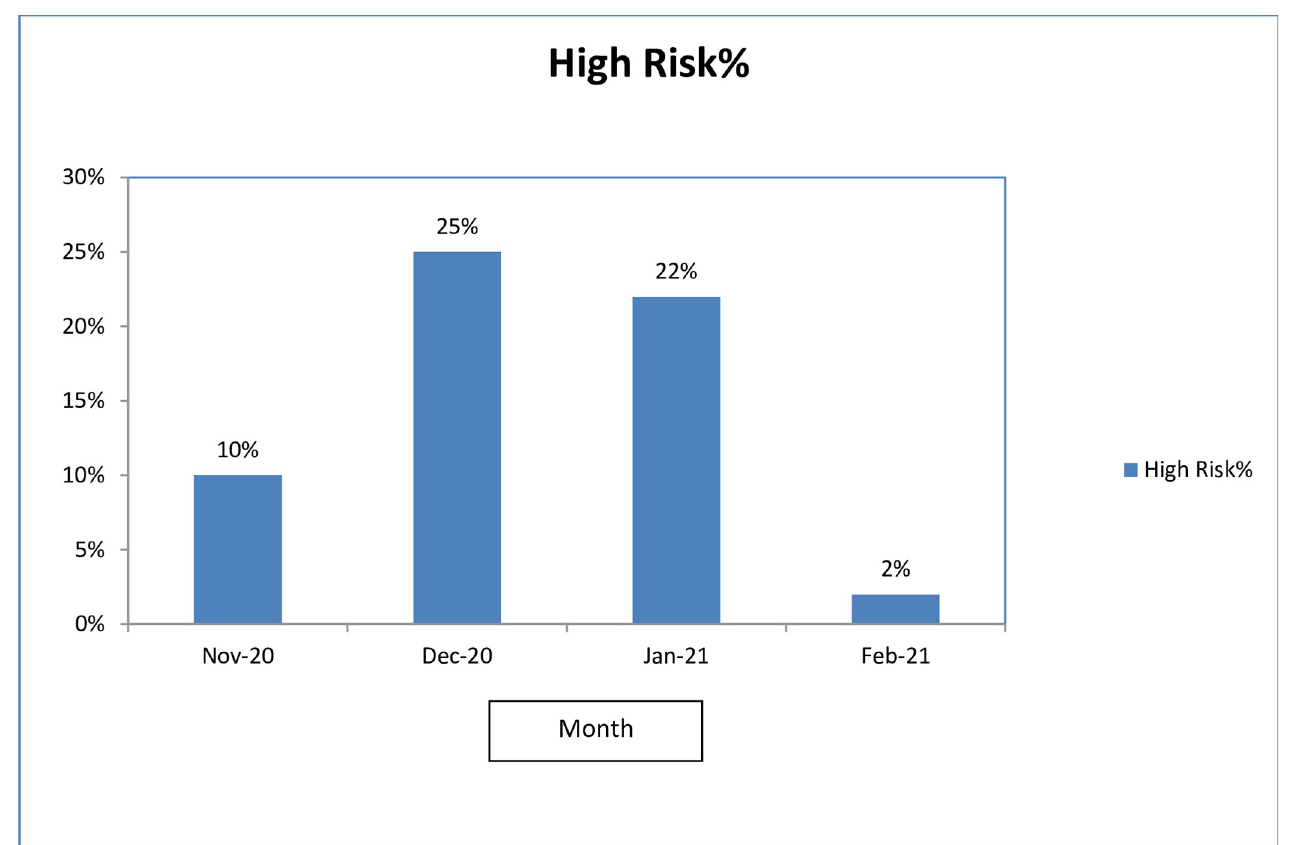
Fig 4. Percentage of HCWs quarantined in each month from November 2020 to February 2021.